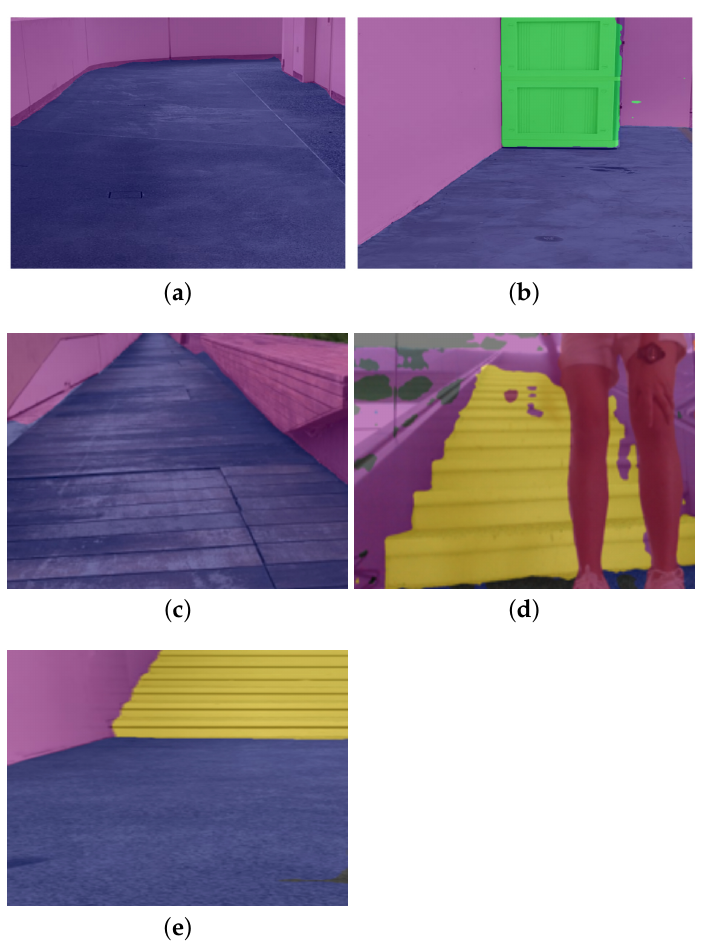
Figure 8. The offline test results of the locomotion mode recognition framework. ( a ) Floor and wall. ( b ) Floor, wall, and static object. ( c ) Floor and wall. ( d ) Stairs, person, and wall. ( e ) Floor, stair, and